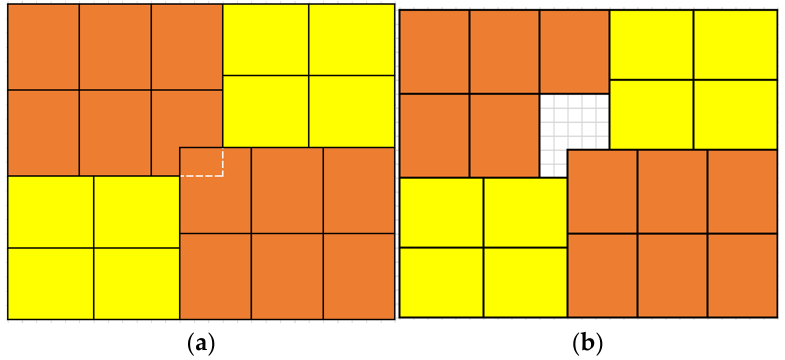
Figure 10. Single object overlap. ( a ) Before removal. ( b ) After removal.